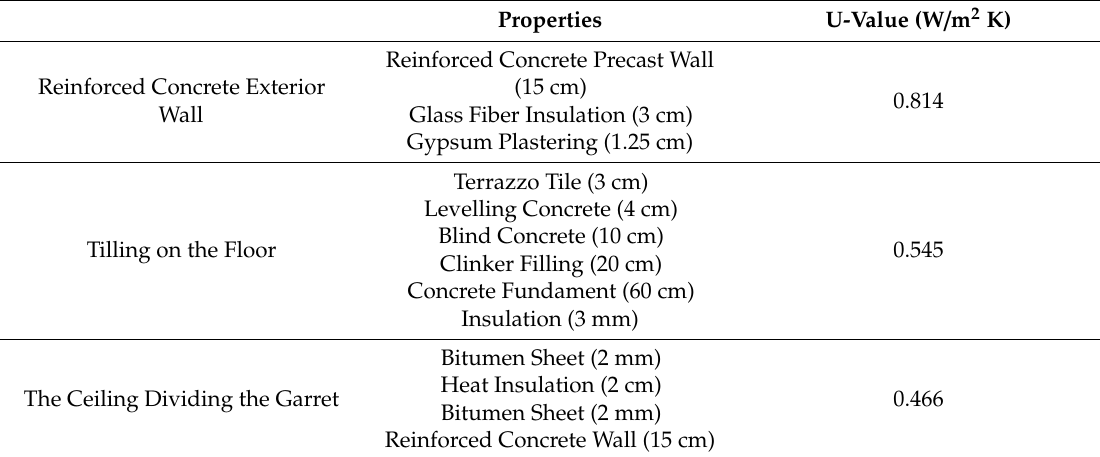
Table 6. Courtyard alternatives by using adiabatic building mass.